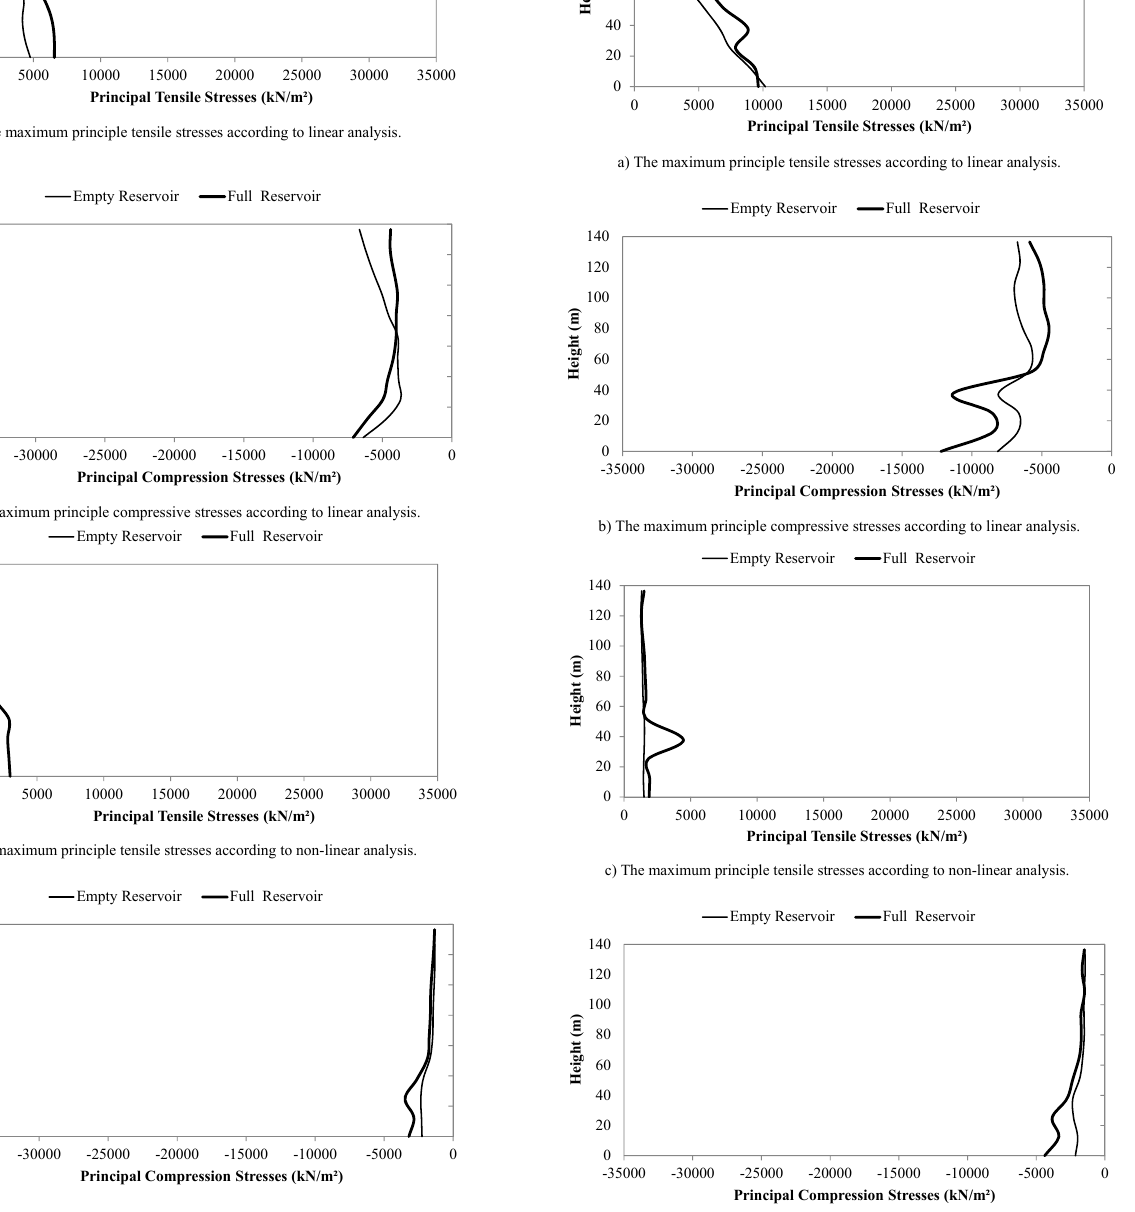
Fig. 22. The maximum principle stress components in IV-IV section.